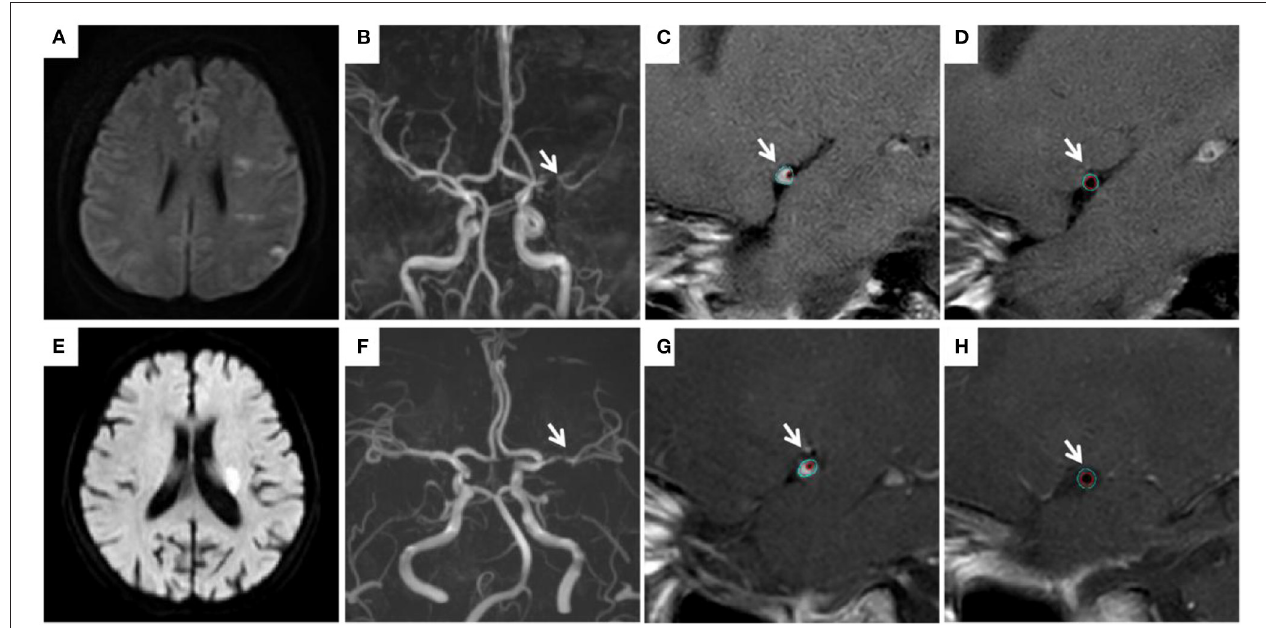
FIGURE 2 | Measurement of vessel plaque characteristics. In a young patient (31 years old) with an infarction in the left hemisphere (A) , left MCA stenosis (B) was observed. TVA was 7.81 mm 2 at the MLN site (C) vs. 7.10 mm 2 at the reference site (D) . RI is 1.1. In a old patient (68 years old) with an infarction in the left basal ganglia (E) , left MCA stenosis (F) was observed. TVA was 7.46 mm 2 at the MLN site (G) vs. 8.12 mm 2 at the reference site (H) . RI is 0.92. MCA, middle cerebral artery; MLN, maximum lumen narrowing; TVA, total vessel area; RI, remodeling